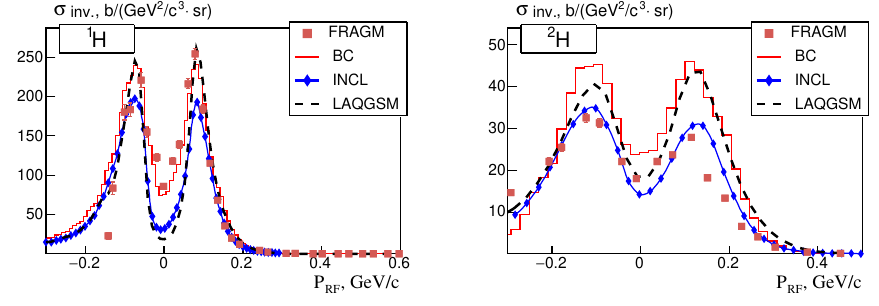
Figure 2. Invariant cross sections of the fragment momentum in the rest frame of iron projectile nucleus in comparison with di ff erent models of ion-ion